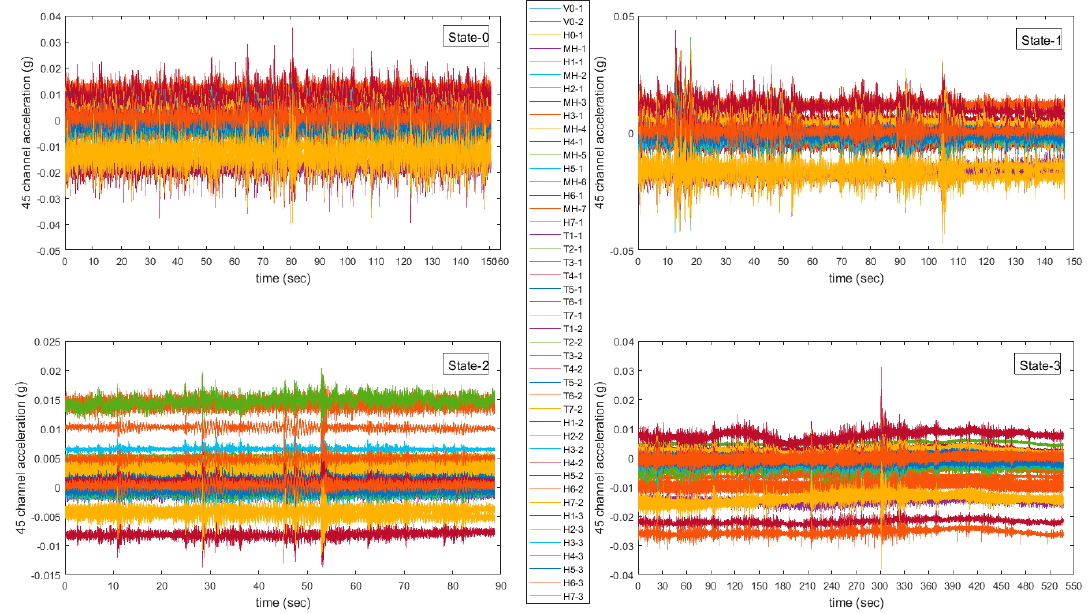
Figure 4. Row data from 45-channel accelerometers.